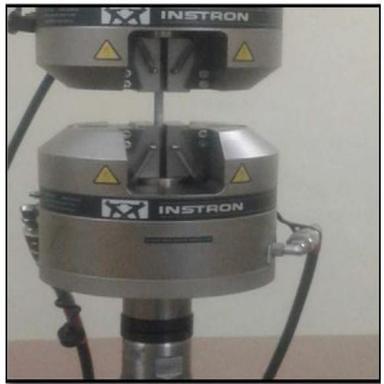
Tensile testing of 31% sample.